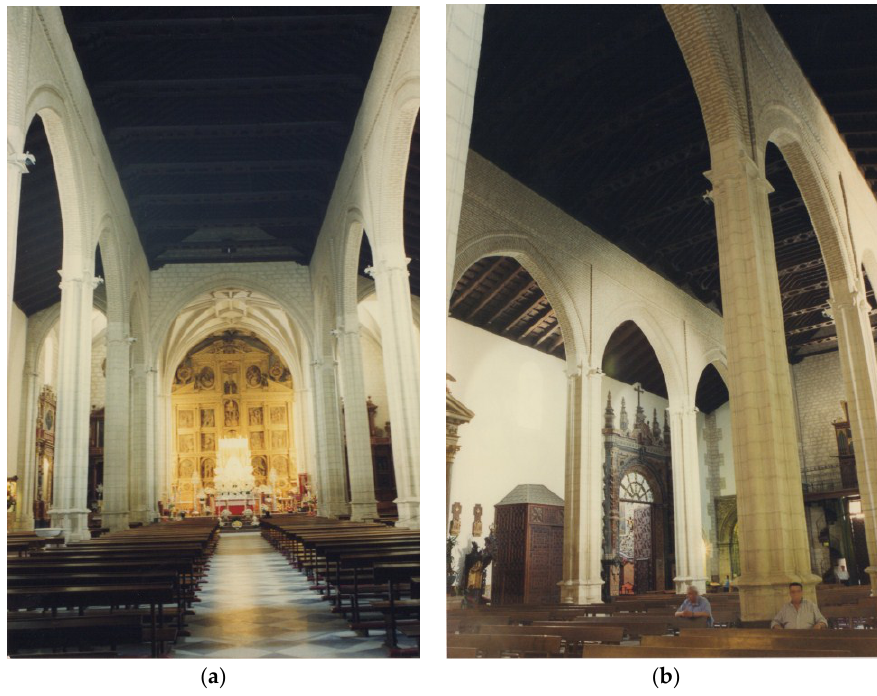
Figure 12. Parish church of San Mateo. Lucena (Cordoba): ( a ) central nave; ( b ) wall-ribs. Photos took by author.